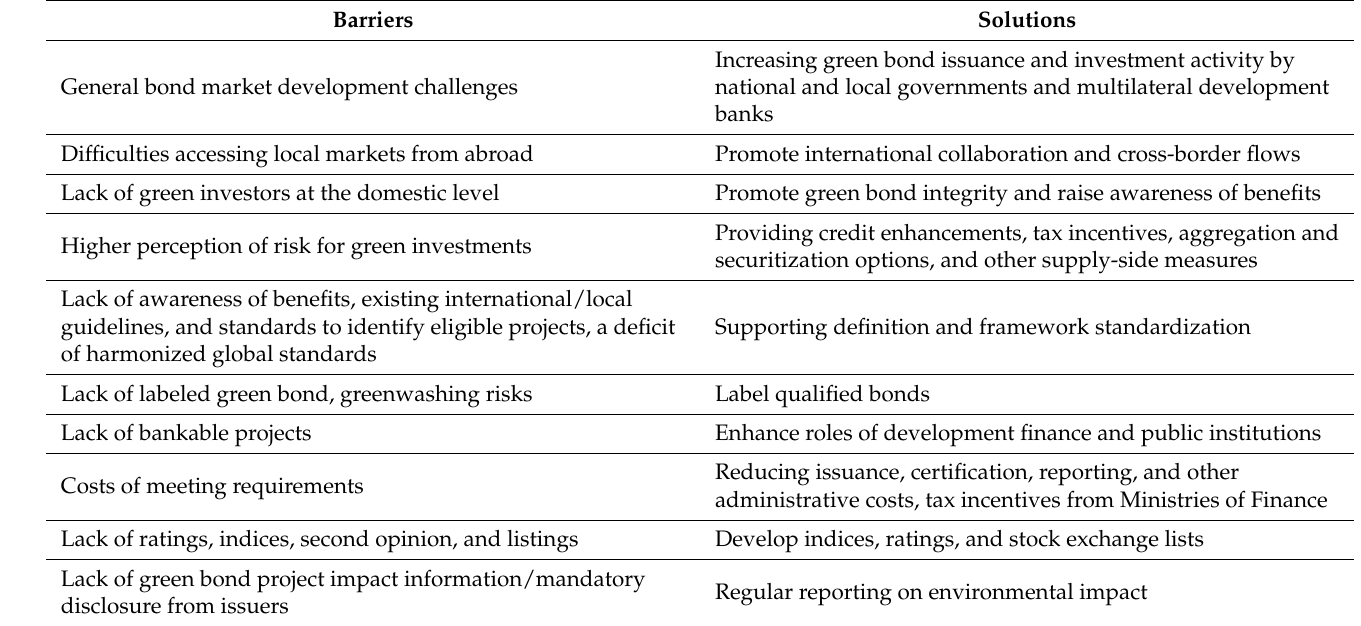
Table 1. Green bond market barriers and